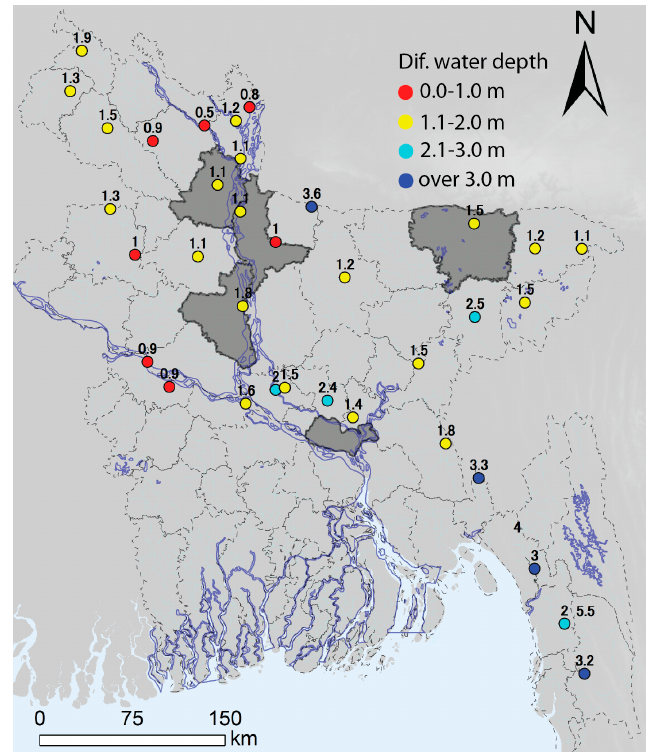
Figure 2. Pilot country: water level gauge stations (points) in a nationwide river network (blue lines) of Bangladesh and visited district for field verification (dark gray).